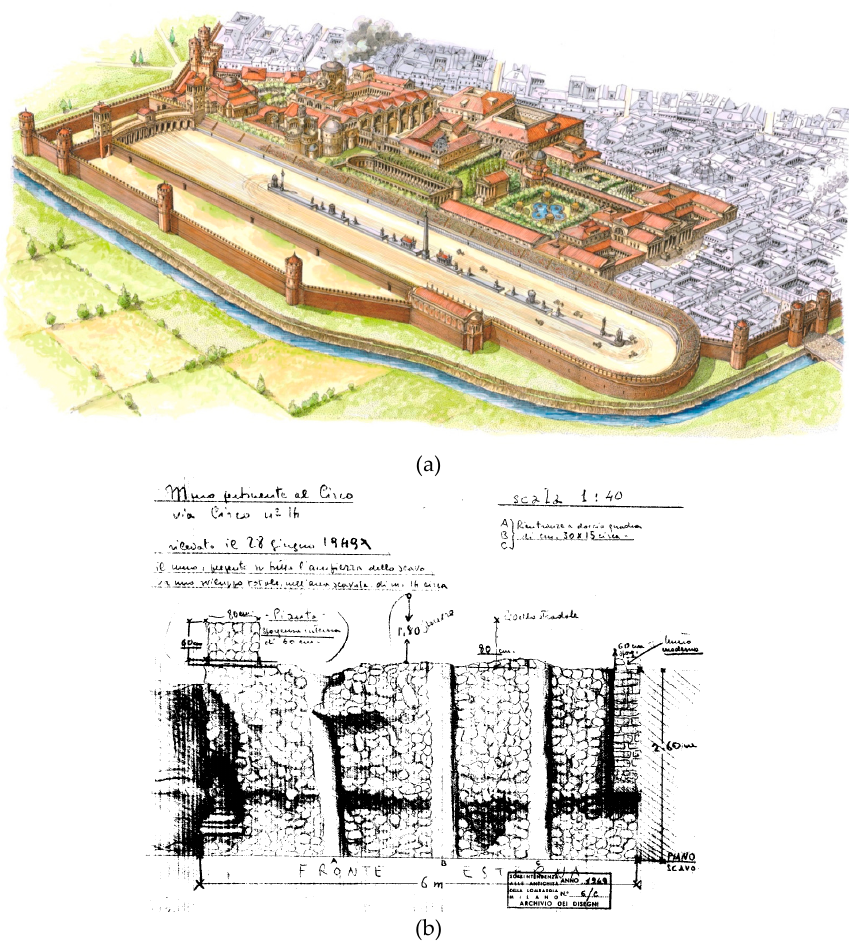
Figure 1. Different types of archival data: ( a ) reconstructive drawing of the Circus and the Imperial Palace (F. Corni, courtesy of Civico Museo Archeologico di Milano); ( b ) drawing of an archaeological excavation carried out at Via Circo 14 in 1949 (courtesy of Ministero dei beni e delle attivit à culturali e del